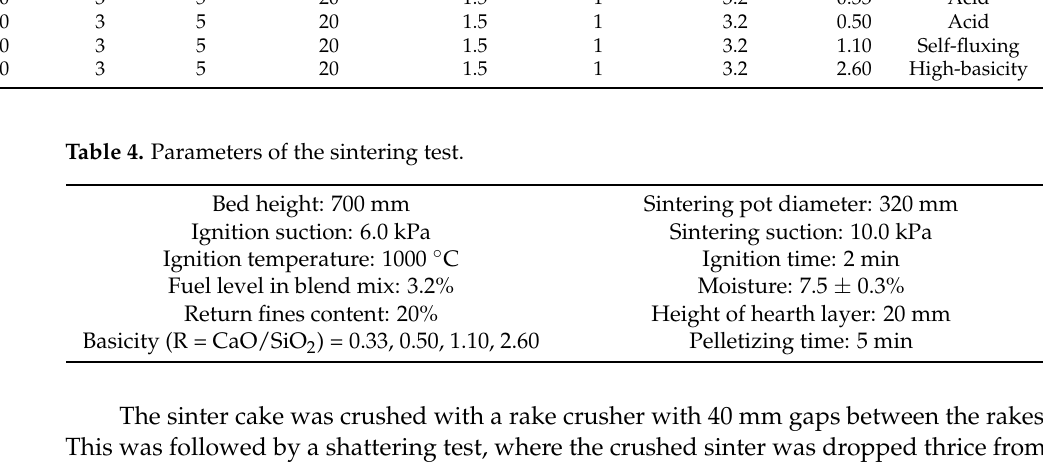
Table 3. Ore-matching scheme of sintering (%).